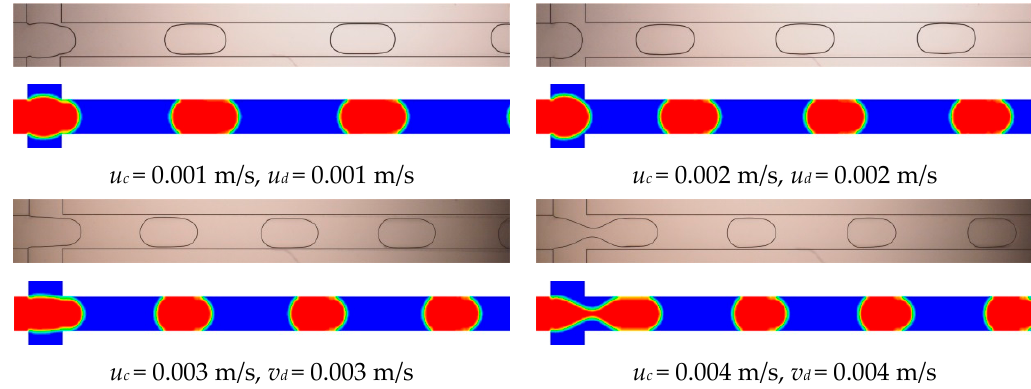
Figure 4. Flowing pattern comparison of experimental results (up) and simulated results (down).